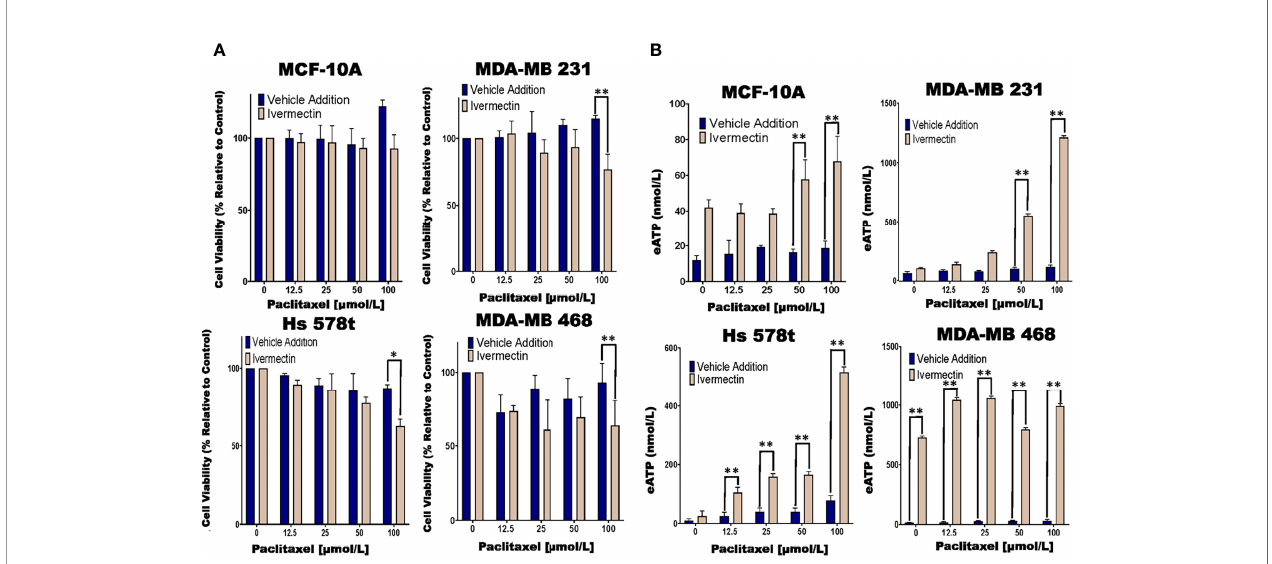
FIGURE 5 | Determining relative eATP content and cell viability in paclitaxel-treated cells in the presence of ivermectin or vehicle addition. (A) The graphs represent cell viability as measured using the Presto Blue HS assay +/- standard deviation from three independent experiments performed in triplicate in TNBC and MCF-10A cells after six hours of treatment with increasing concentrations of paclitaxel and the P2RX4 and P2RX7 activator ivermectin (10 µmol/L) or vehicle addition. (B) eATP content was measured in the supernatants of paclitaxel-treated TNBC and MCF-10A cell lines in the presence of the P2RX4 and P2RX7 activator ivermectin (10 µmol/L) or vehicle addition. The student ’ s t-test was applied to the applicable assays to ascertain signi fi cance. * represents p < 0.05 and ** represents p < 0.01 when comparing ivermectin to vehicle addition.